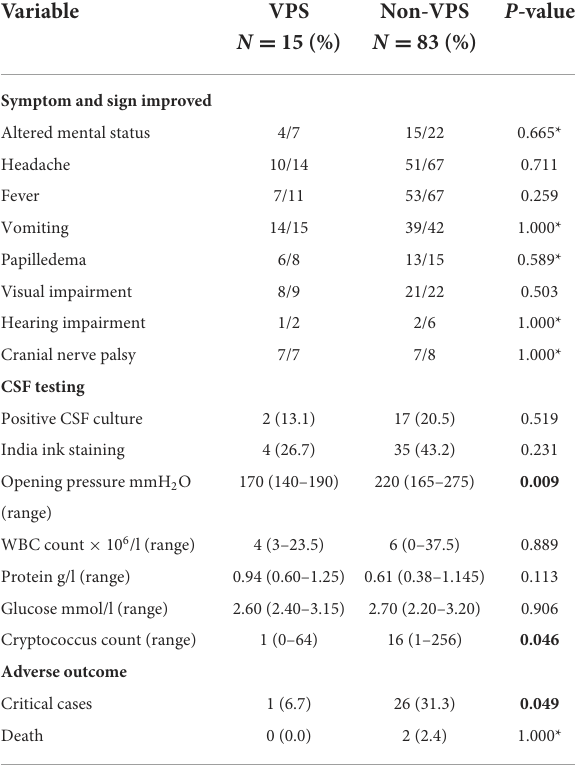
TABLE 3 Follow up with VPS and non-VPS patients at least 1 years after they were discharged from